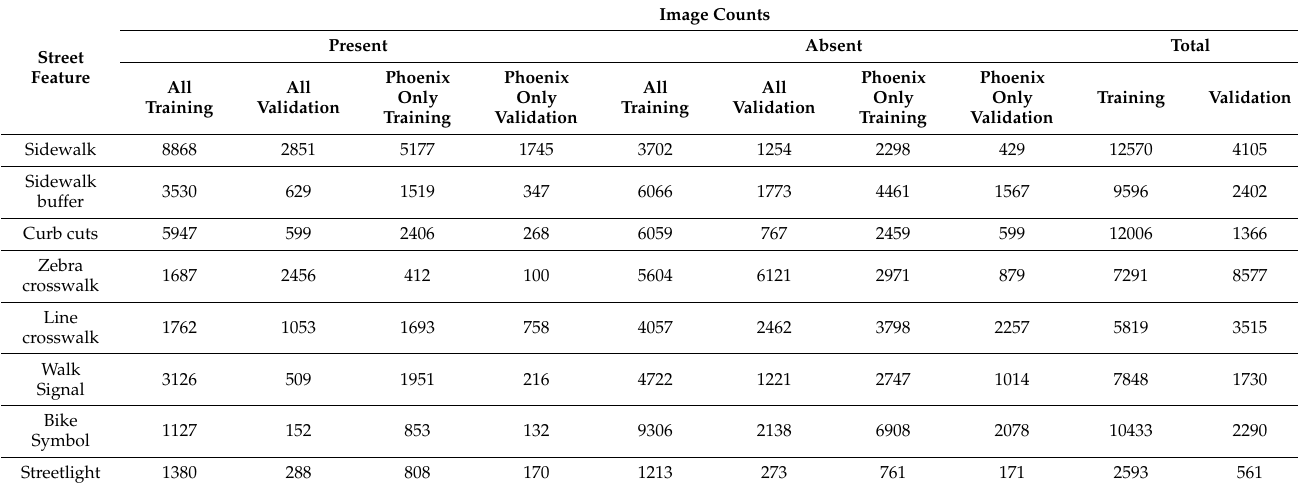
Table 1. Summary of the number of images used for training and validation datasets.